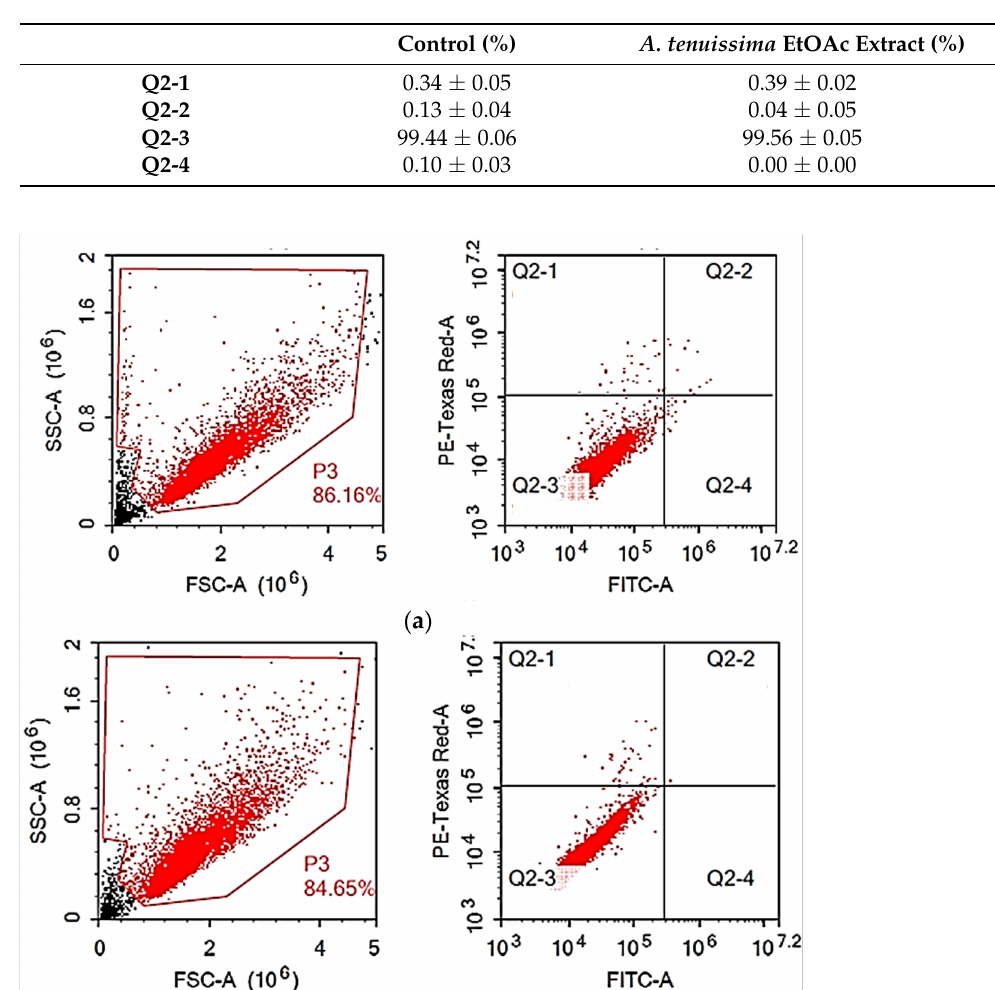
Table 3. Apoptosis/necrosis assessment in MCF7 cell line after exposure to A. tenuissima EtOAc extract and control for 24h.